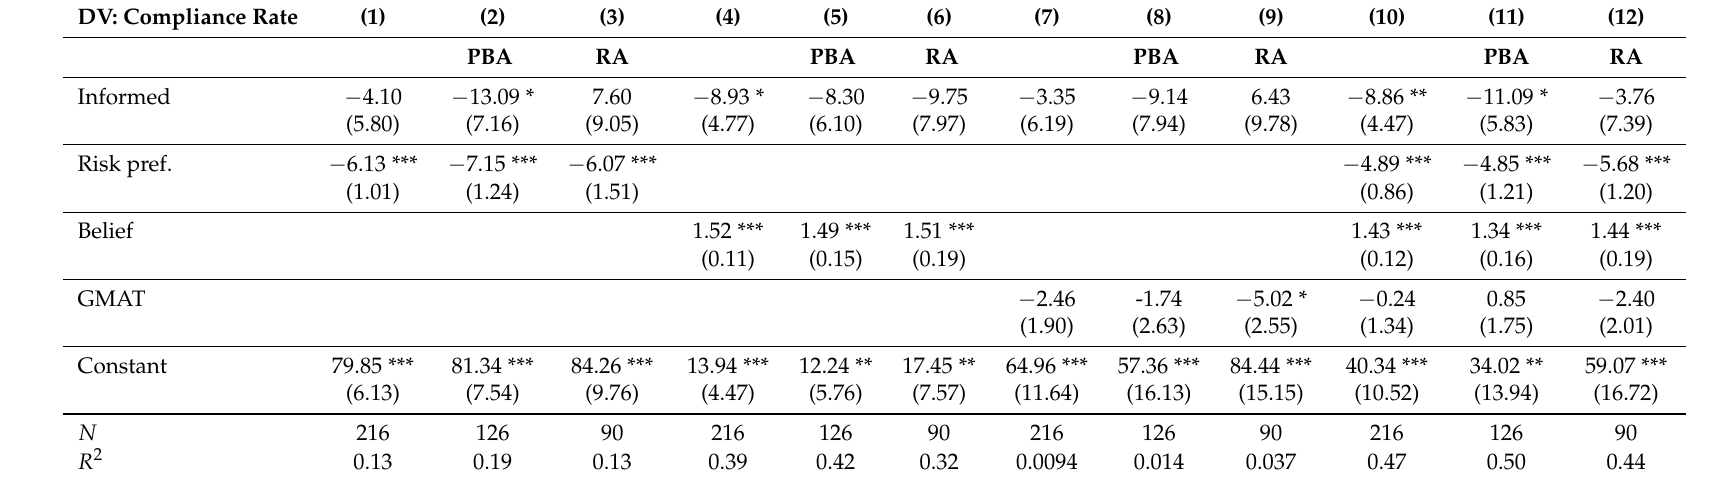
Table A3. Information treatment regressions (OLS) with